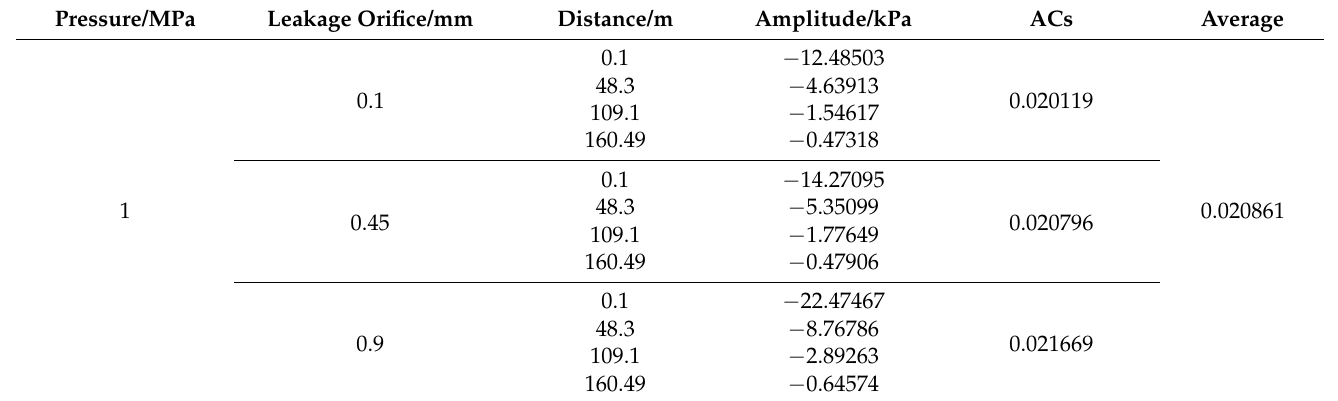
Table 5. The fitted ACs when acoustic waves propagate downstream.